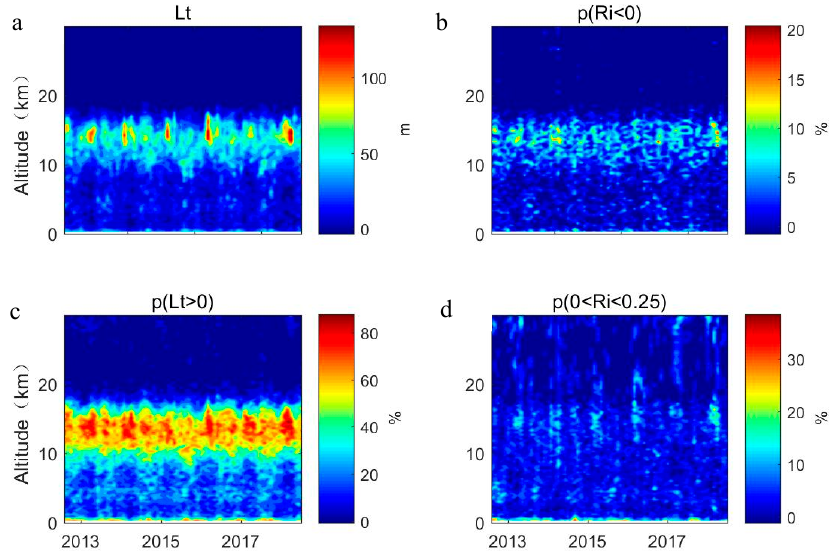
Figure 6. ( a ) Monthly means for the Thorpe length L T , ( b ) monthly occurrence rates of R i < 0, ( c ) monthly occurrence rates of L T > 0, ( d ) monthly occurrence rates of 0 < R i < 0.25 .